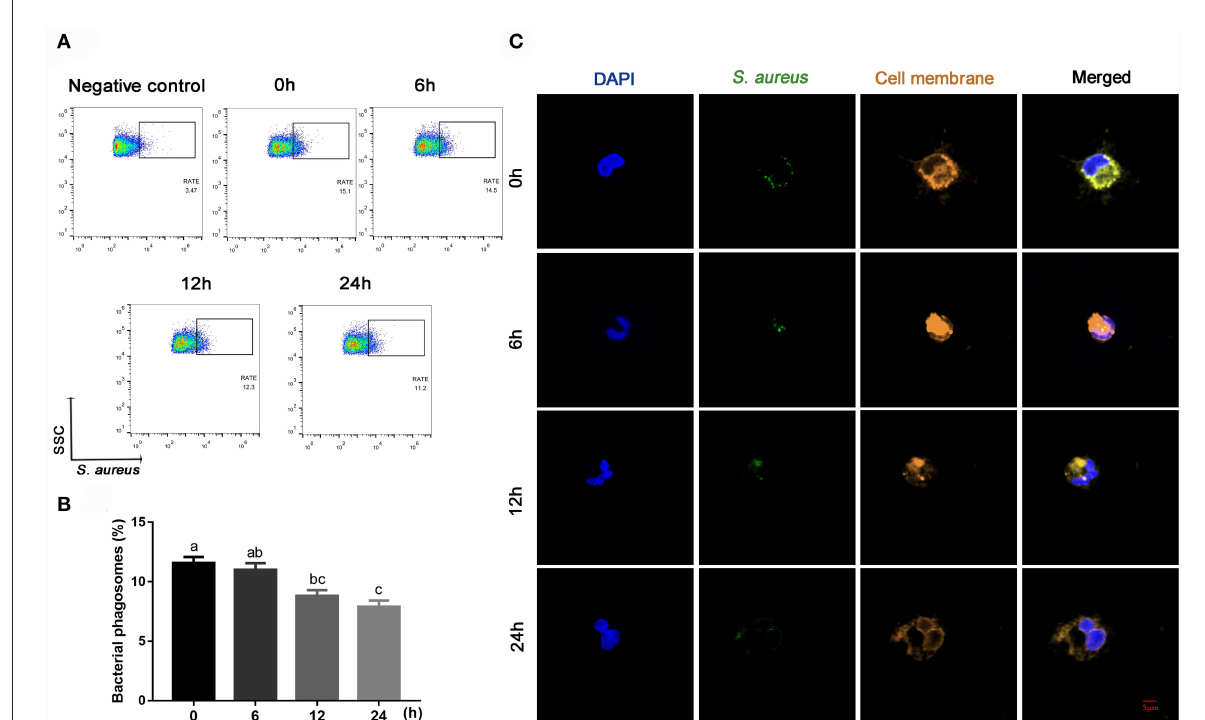
FIGURE6 Effects of β -Hydroxybutyrate (BHB) on phagocytosis of CD14 + monocytes. The monocytes were treated with 3.0 m M of BHB for 0, 6, 12 or 24h, and then infected with live green-fluorescence-labeled Staphylococcus aureus (10 S. aureus with green fluorescence per cell) for 1h. (A,B) Phagocytosis of monocytes, RATE, proportion of positive cells in 10,000 cells. (C) Representative images of Staphylococcus aureus (green) and cell membrane (orange), scale bar = 5 µ m. Comparisons among groups were calculated using a one-way ANOVA with subsequent Bonferroni correction. Data are means ± SEM of three independent experiments. Different lowercase letters in the bar chart indicate significant differences ( P <